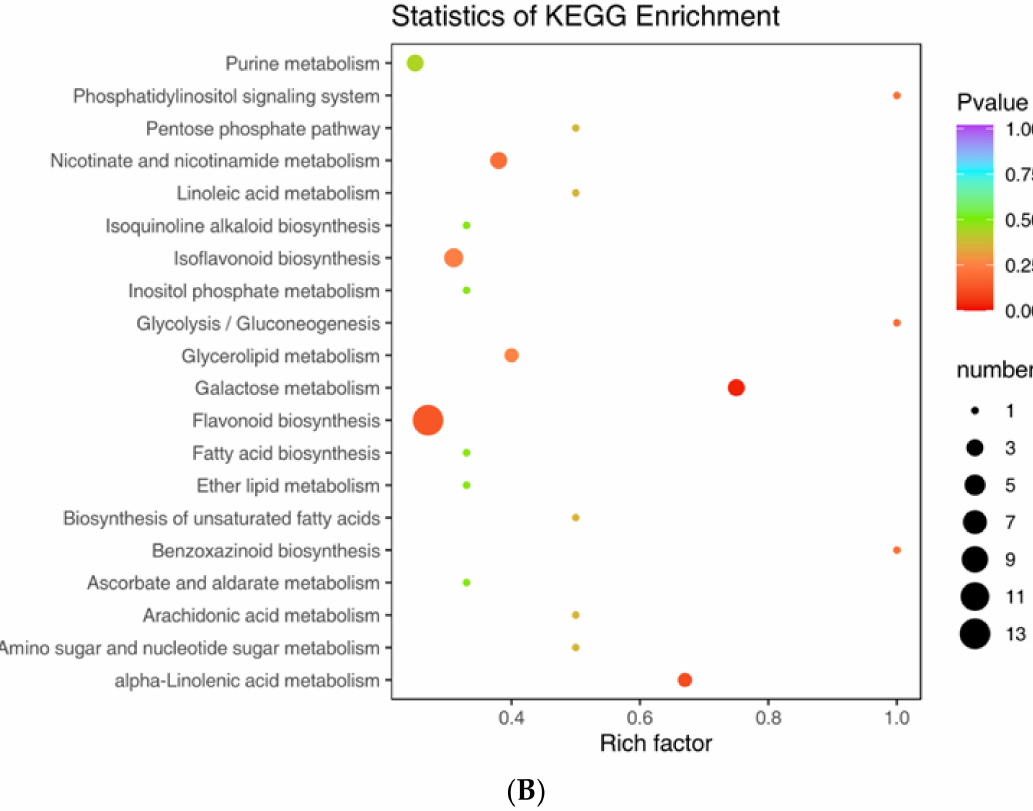
Figure 5. K-means plot and KEGG pathways enriched for metabolome DAMs in rice infested by SBPH nymphs compared with the untreated control. ( A ) The DAMs data from samples collected 0 h, 24 h, 48 h, and 72 h after treatment (meta0, meta24, meta48, and meta72) were used for the K-means plot. ( B ) KEGG pathways enriched for DAMs in rice infested by SBPH nymphs at the 48 h time-point compared with the 0 h